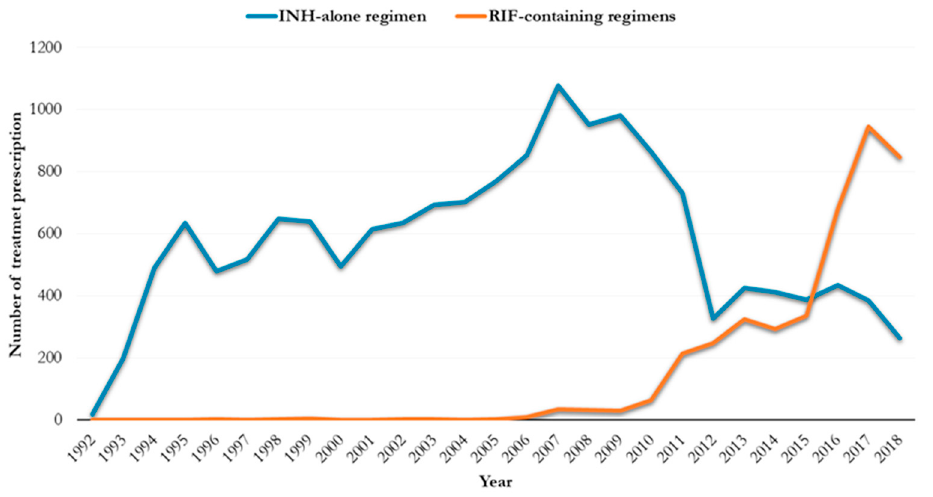
Figure 1. Change in LTBI treatment prescription from INH-alone to RIF-containing regimens ( n = 19,670). Individuals were mainly males (58.8%), foreign-born (73.3%), and with a median (IQR) age of 29